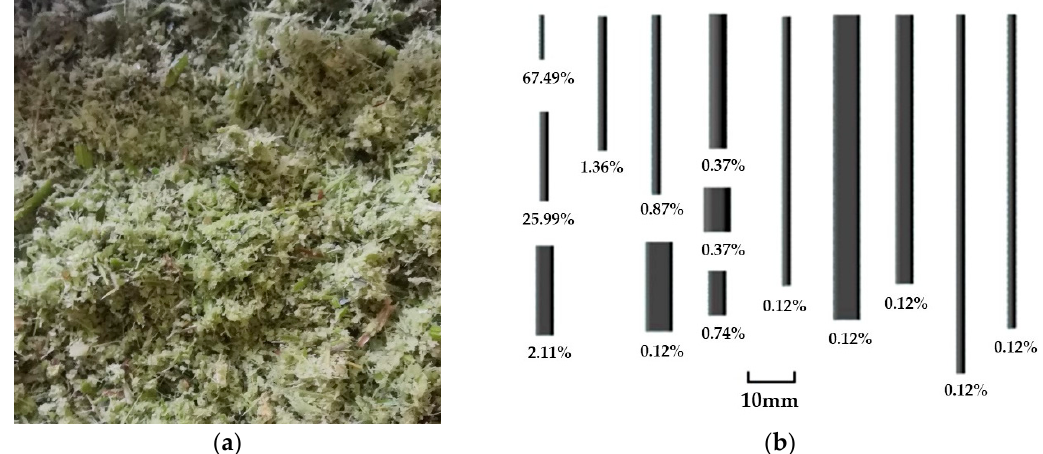
Figure 2. Particles of sweet sorghum bagasse: ( a ) Photograph of sweet sorghum bagasse; ( b ) Shape and particle size distribution.